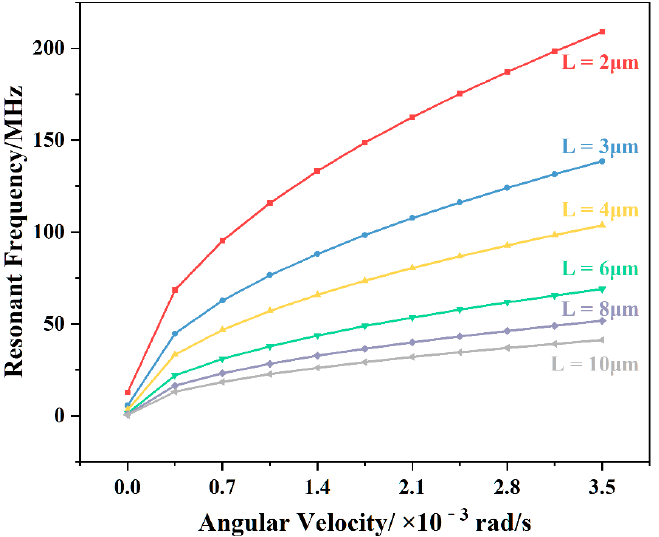
Figure 8. Curves of the resonant frequencies of graphene resonance beams of different lengths against the Coriolis force.